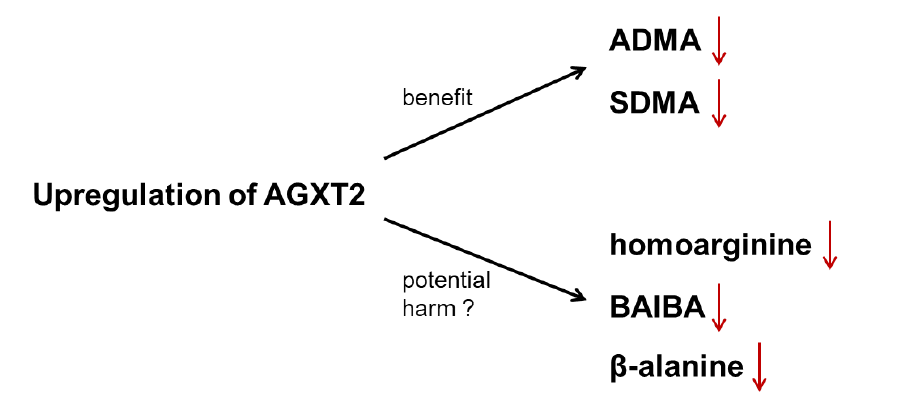
Figure 4. Janus-faced cardiovascular consequences of AGXT2 upregulation. Therapeutic upregulation of AGXT2 may exert a positive e ff ect on cardiovascular system via lowering of ADMA and SDMA. However, there may also be a possible harmful e ff ect caused by lowering of homoarginine, BAIBA and β -alanine